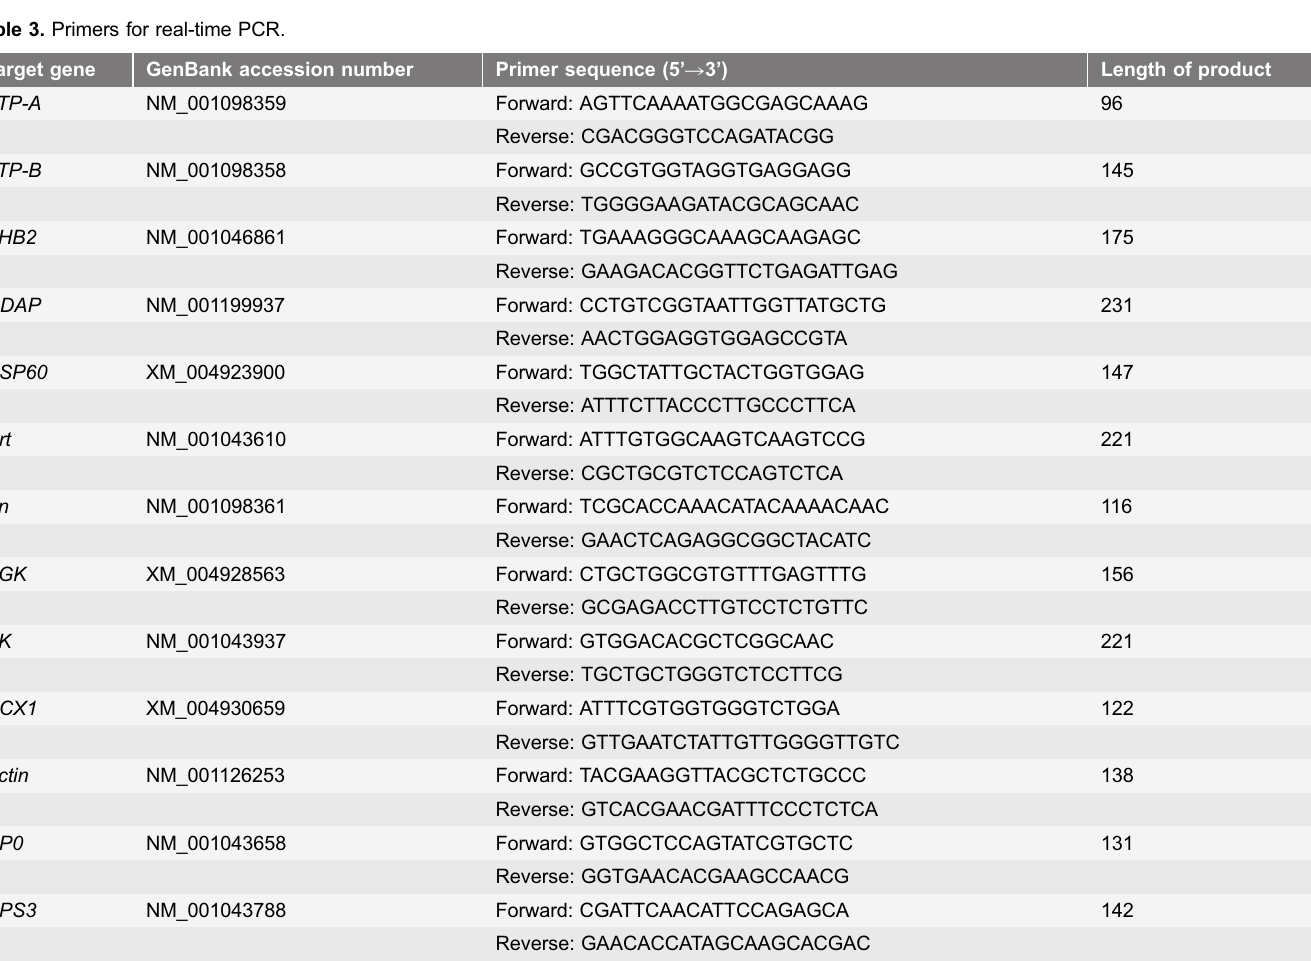
Table 3. Primers for real-time